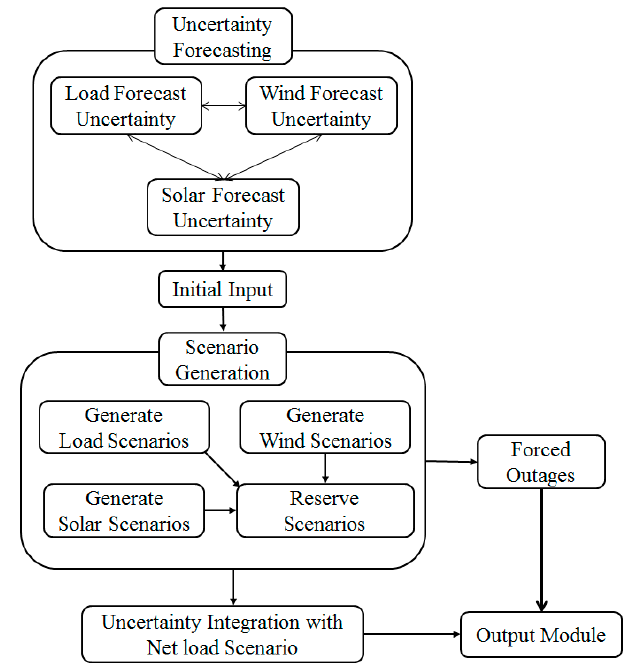
Figure 2. Structure of the uncertainty integration method (UIM).